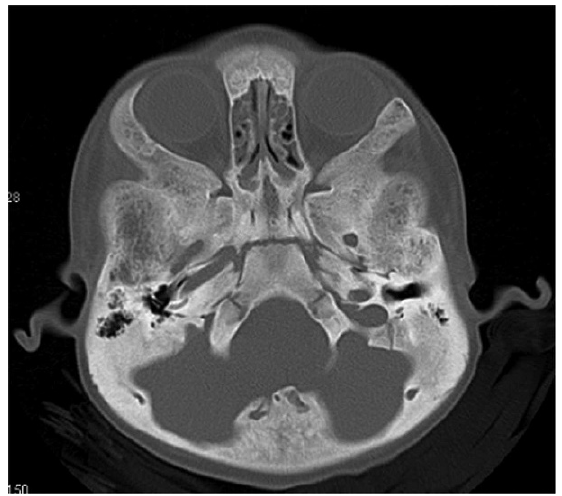
Figure 3 - Anteroposterior hand radiographs show diaphyseal widening associated with hyperostosis and dysplastic terminal phalanges (increased cortex of the tubular